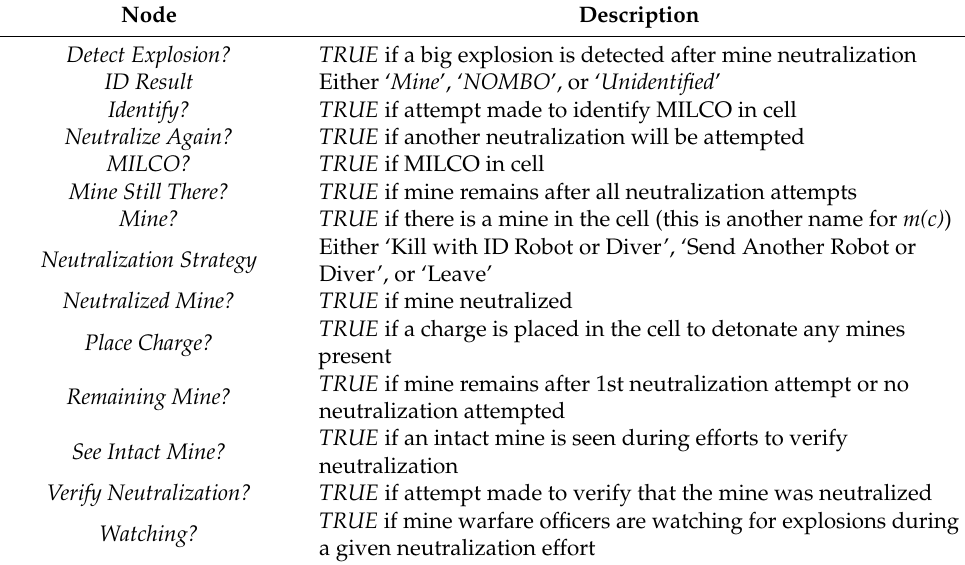
Table 1. The nodes of the Bayesian network. Node